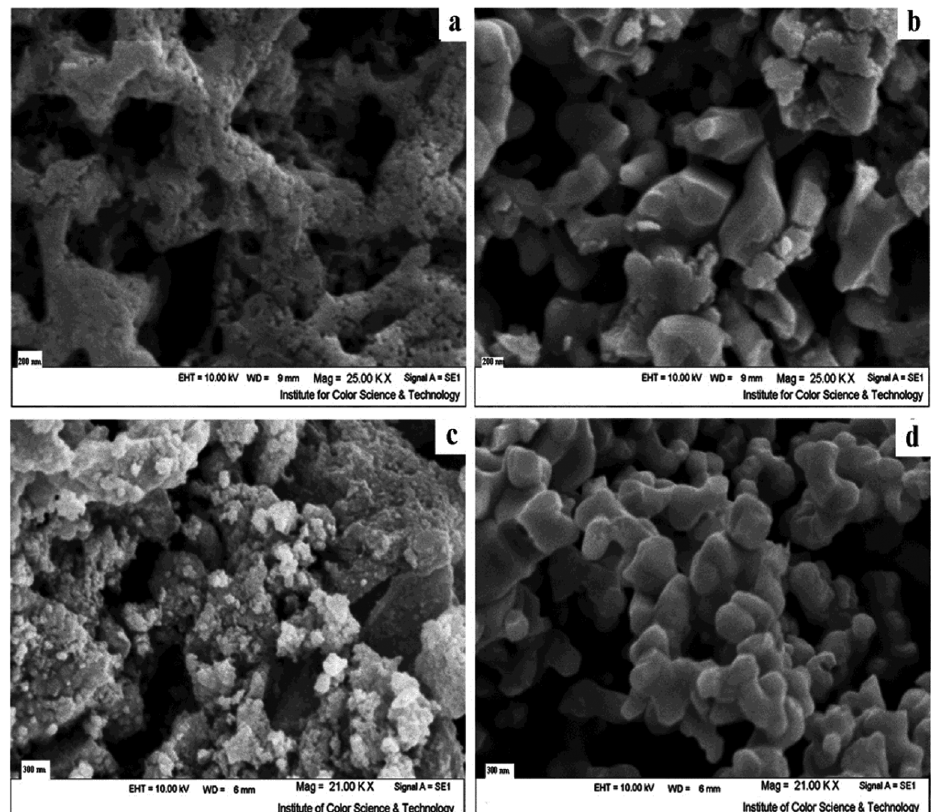
Figure 4: SEM photographs of BiFeO prepared by (a) chitosan polymers, (b) Pechini method, (c) PEG polymer and (d) microwave